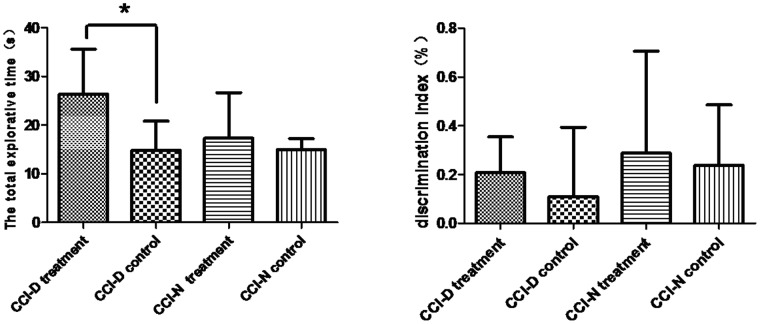
The total exploration time and discrimination index after rhGH treatment.(a) total exploration time (left). (b). discrimination index (right). Note: * P<0.05 between the two groups.